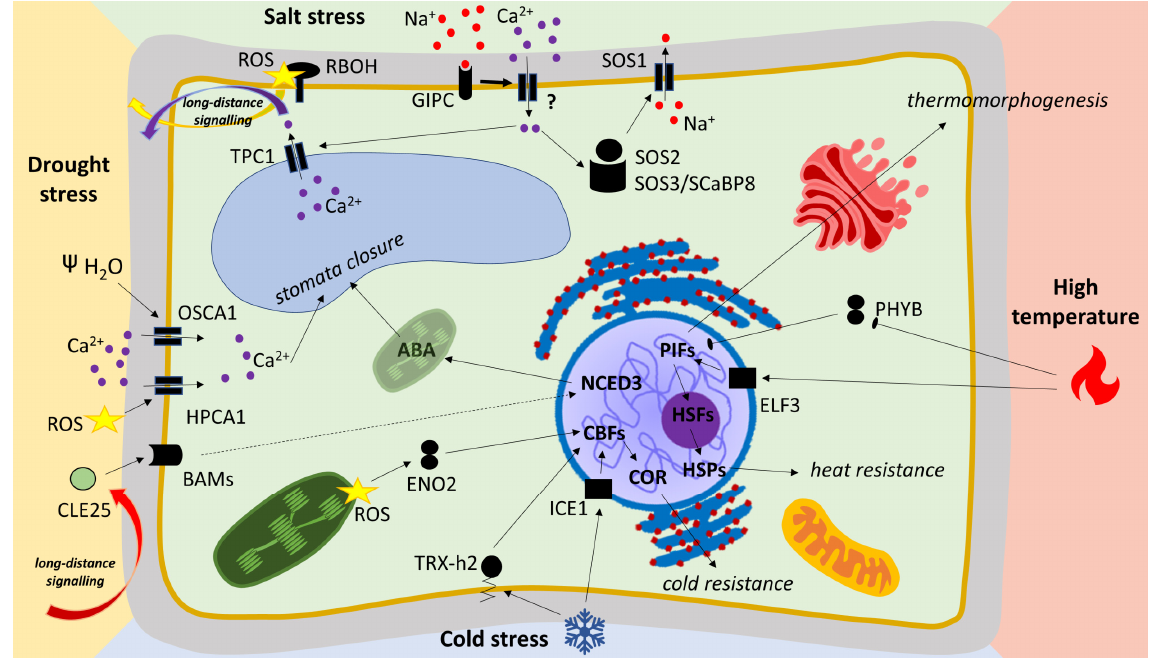
Figure 3. Abiotic stress signaling. Image represents novel mechanisms in abiotic stress signaling reviewed in corresponding sections.